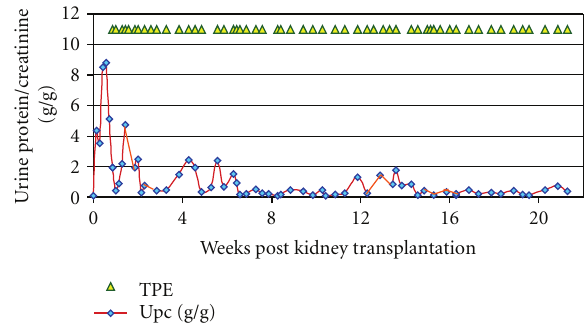
Figure 1: Immediate recurrence of FSGS (rFSGS) following de- ceased donor kidney transplantation. A 15-year-old girl with ster- oid-resistant FSGS had bilateral nephrectomy prior to transplan- tation. Proteinuria recurred within the first 12 hours but was con- trolled with intensive plasmaexchange therapy (1.5 plasma volumes with albumin replacement). E ff orts to wean plasmapheresis lead to a rise in urine protein/creatinine ratio (g/g) on several occasions. Each triangle represents a plasma